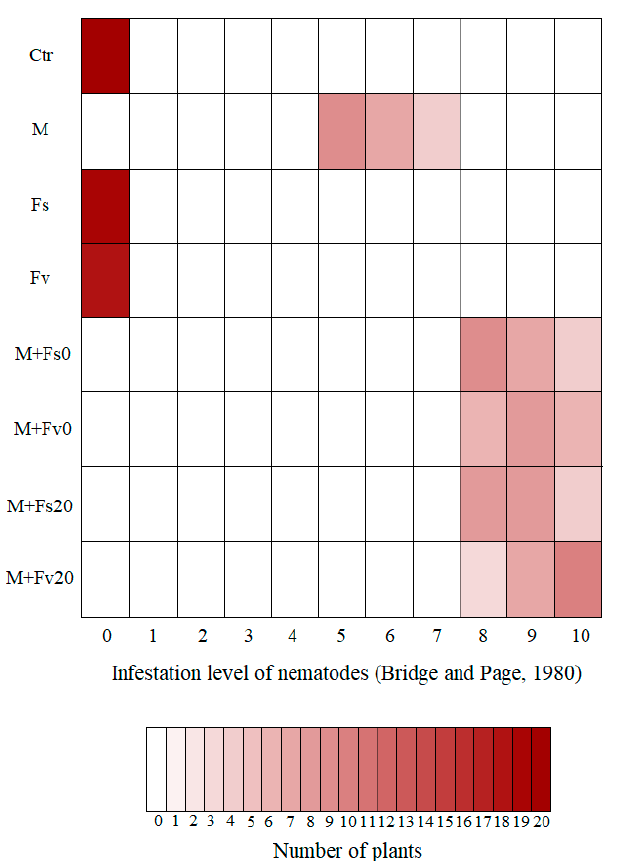
Fig. 8: Percentage of chlorotic leaves of inka nut plants during the presence of Meloidogyne incognita and Fusarium spp. A) Percentage of chlo- rotic leaves measured at intervals of 10-days for 80 days after initial inoculation, mean and standard deviation; B) Chlorophyll content in leaves of inka nut plants during the presence of M. incognita and Fusarium spp., after 90-days of treatment. Error bars indicate stan- dard deviation (± S.D.). Columns with the same letter are not signi- fi cantly different ( p <0.05).